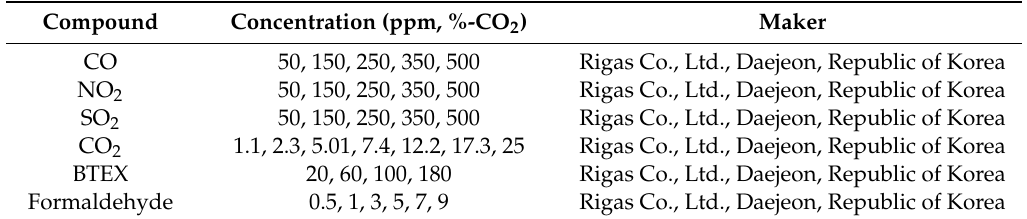
Table 1. Concentrations of target gases used in this study. BTEX: benzene, toluene, ethylbenzene and